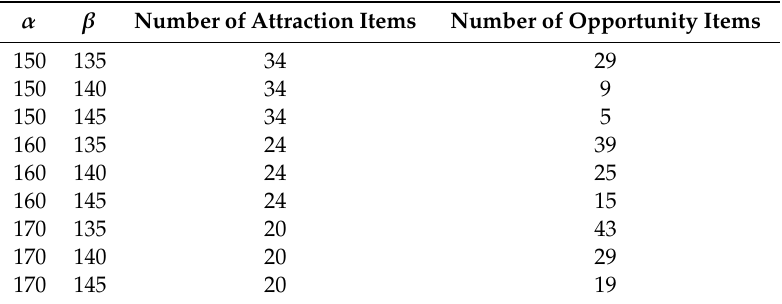
Table 8. Number of attraction and opportunity items using closeness